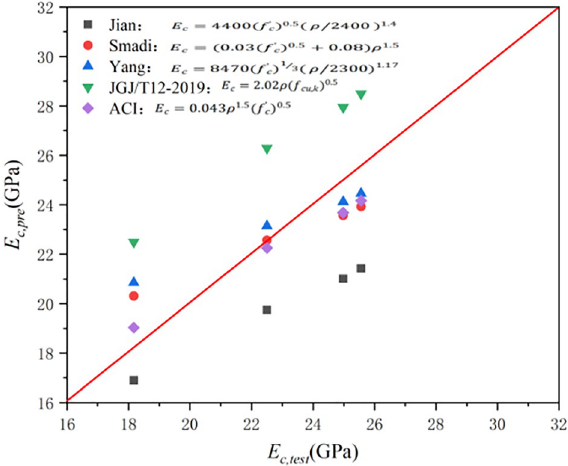
Figure 11. Comparison between calculated and experimental values of elastic